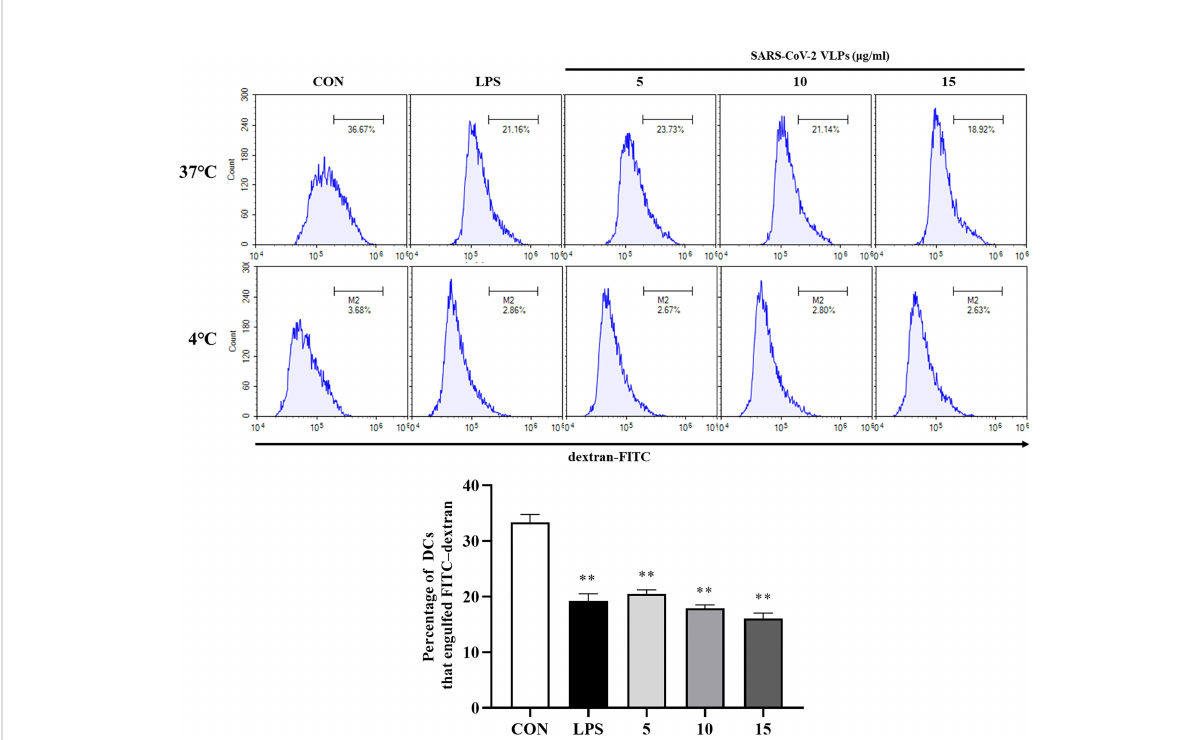
FIGURE 4 SARS-CoV-2 VLP-treated DCs had diminished endocytic capacity. The endocytic capacity of DCs was assessed using FITC-conjugated dextran uptake system at 37°C and 4°C (as a negative control) via fl ow cytometry. Values are the means ± SE of three independent experiments. ** P < 0.01 versus untreated DCs